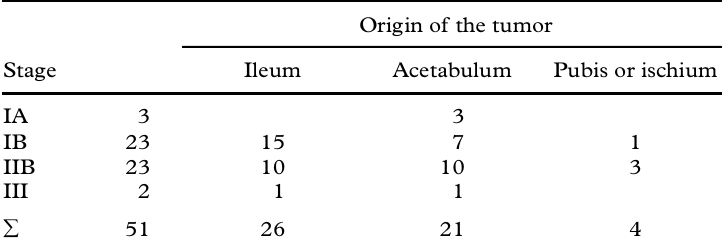
Table 1. Stage and origin of 51 patients with pelvic